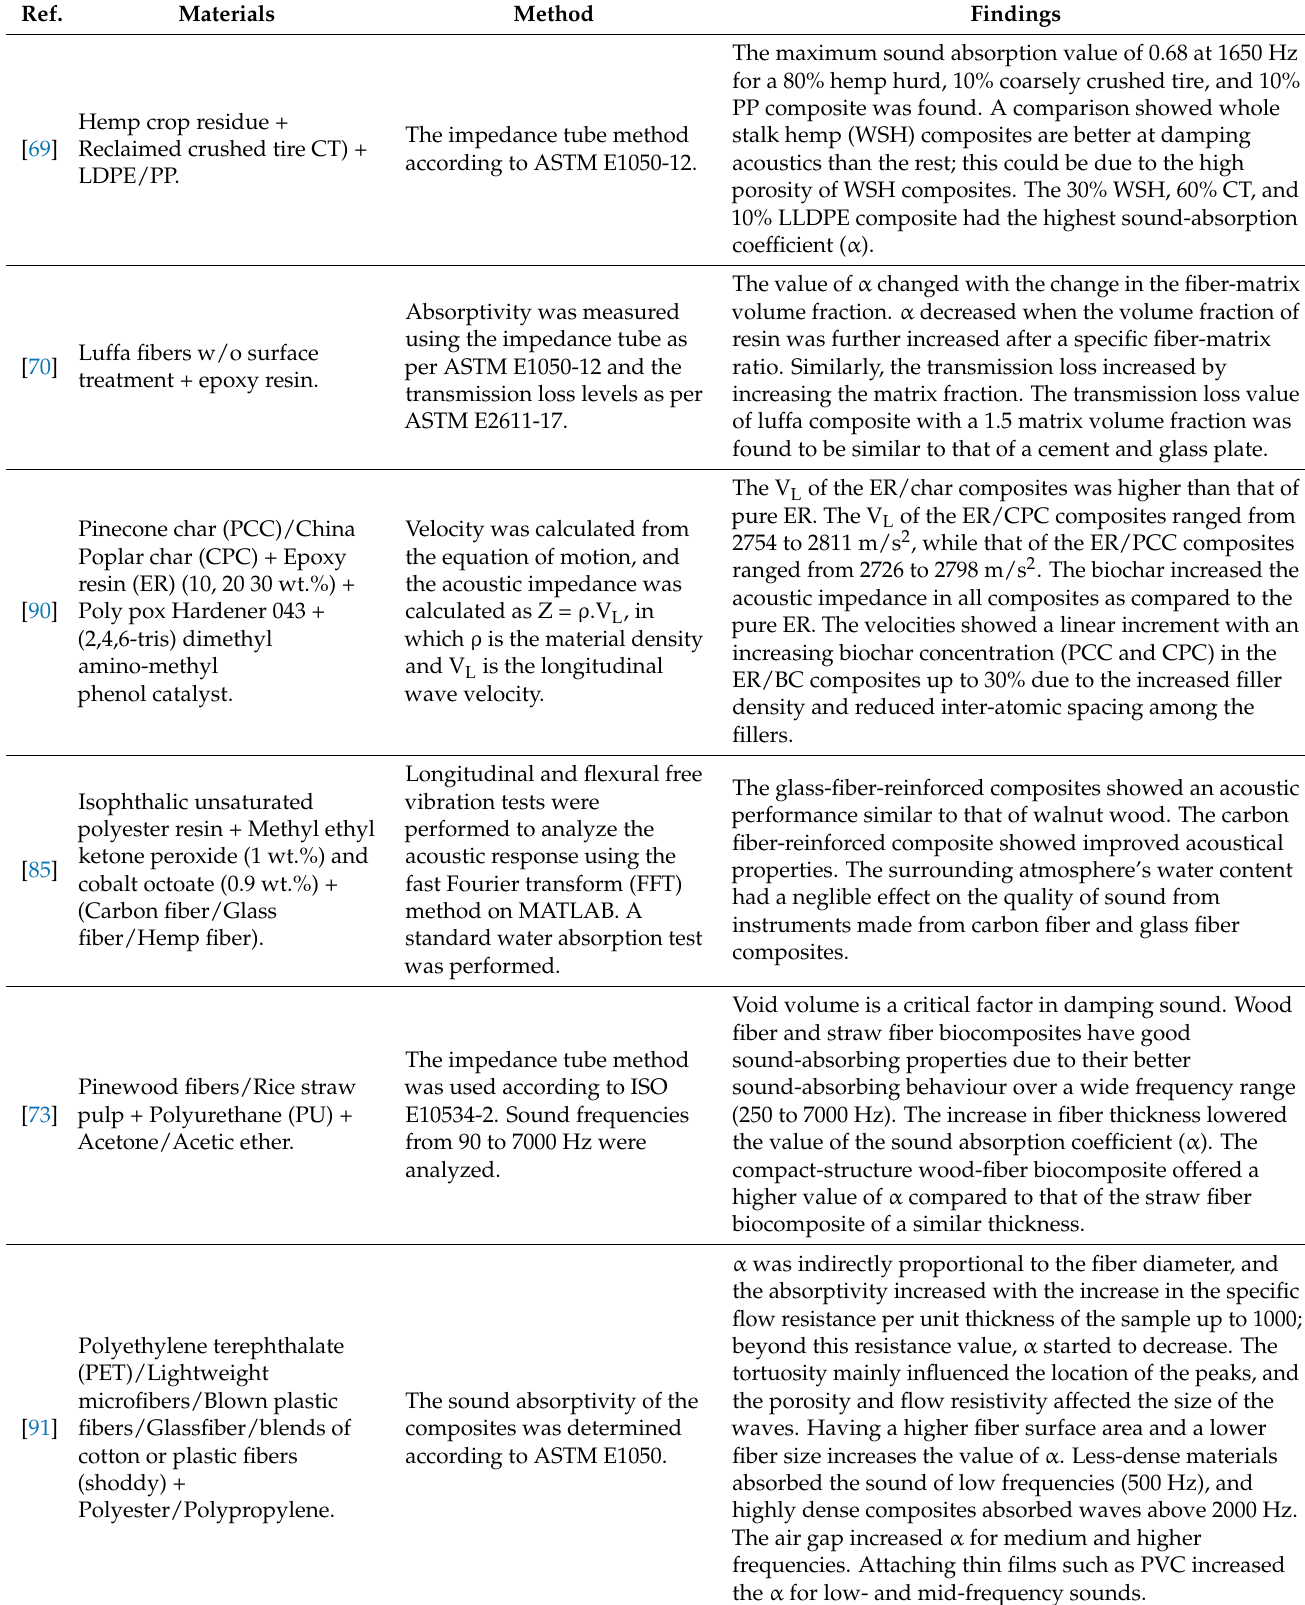
Table 1. Biofiber-reinforced material for acoustic